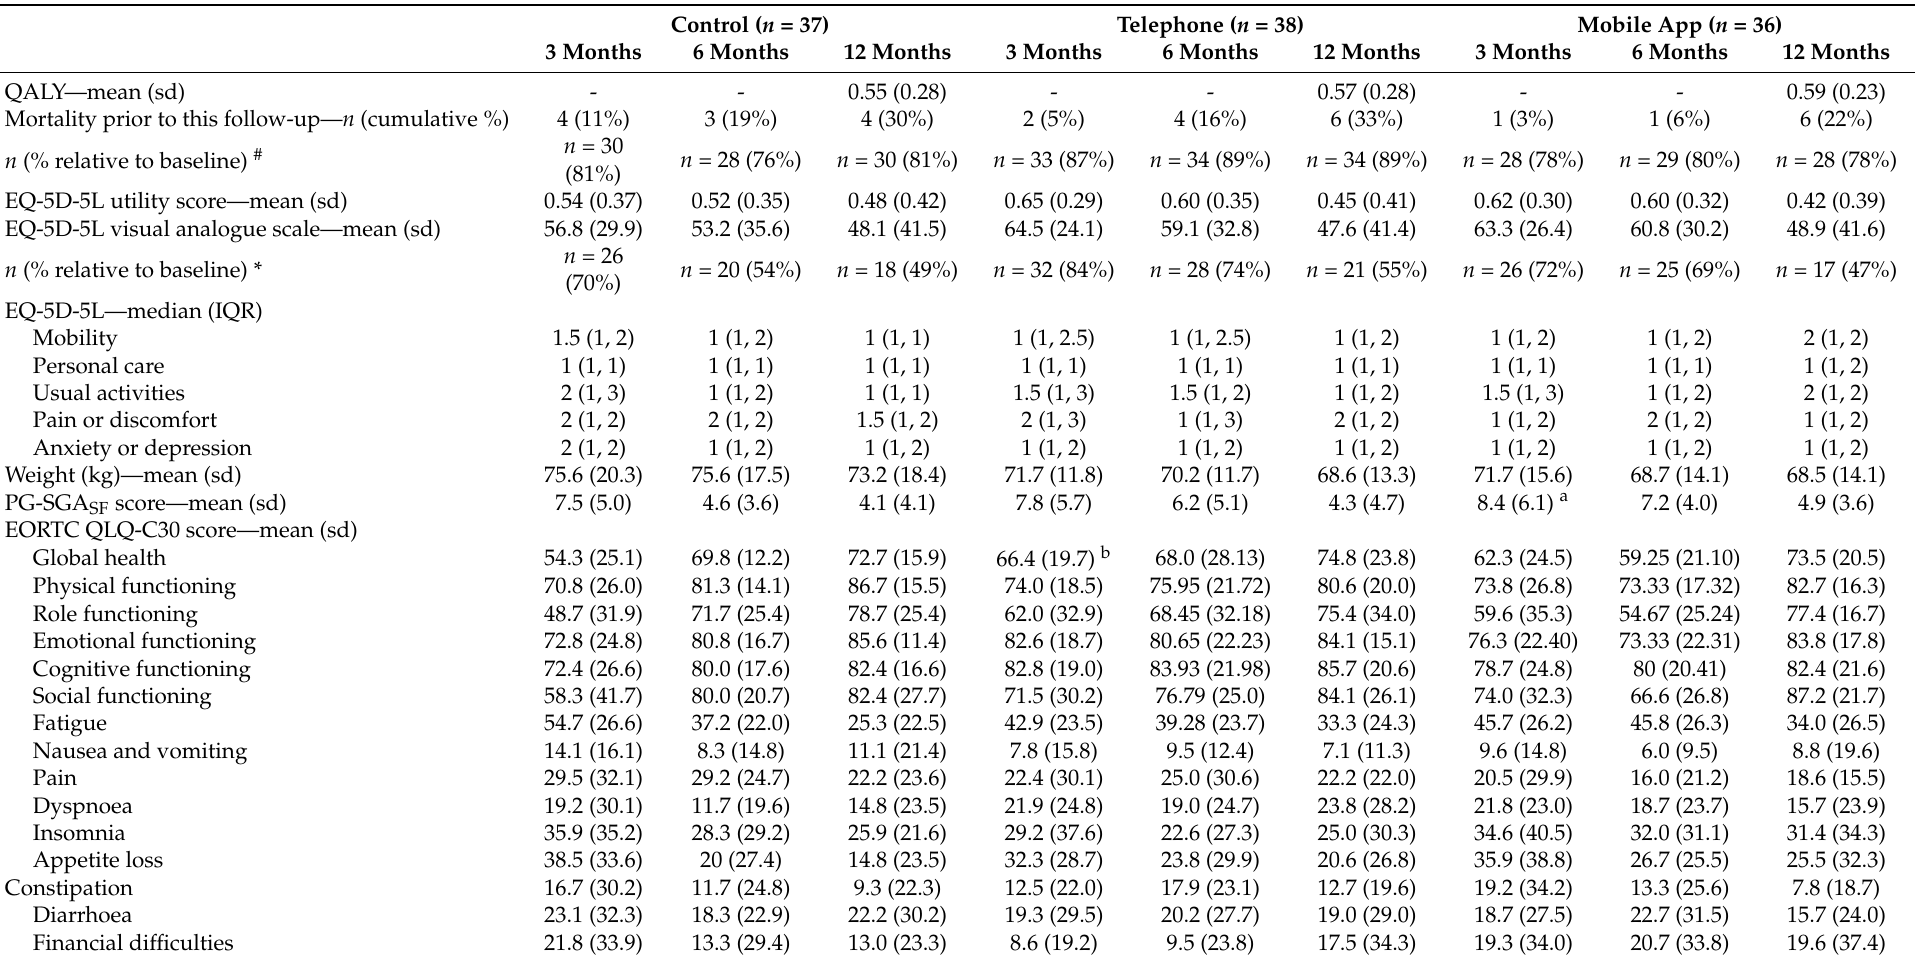
Table 3. Summative outcomes by group at each